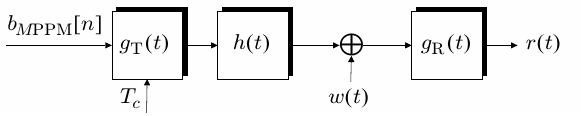
Figure 2. Chip based PPM transmission